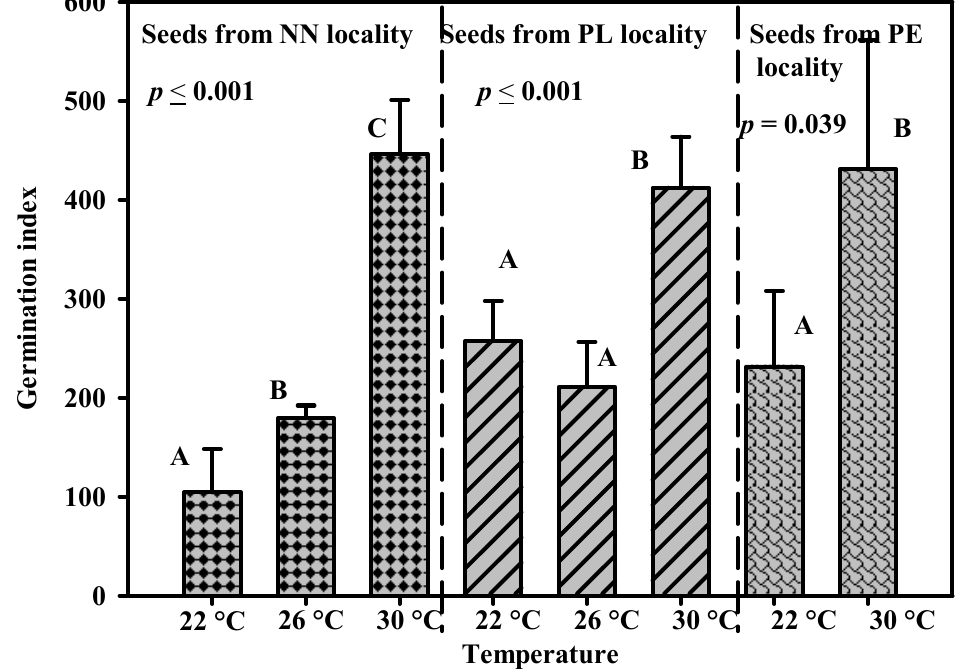
Figure 5. ANOVA results for comparison of the effect of temperature on the germination index of seeds collected in the Sirhin (NN), Firmihin (PL), and Skant (PE) localities. Means with the same letter are not significantly different from each other ( p = 0.05).